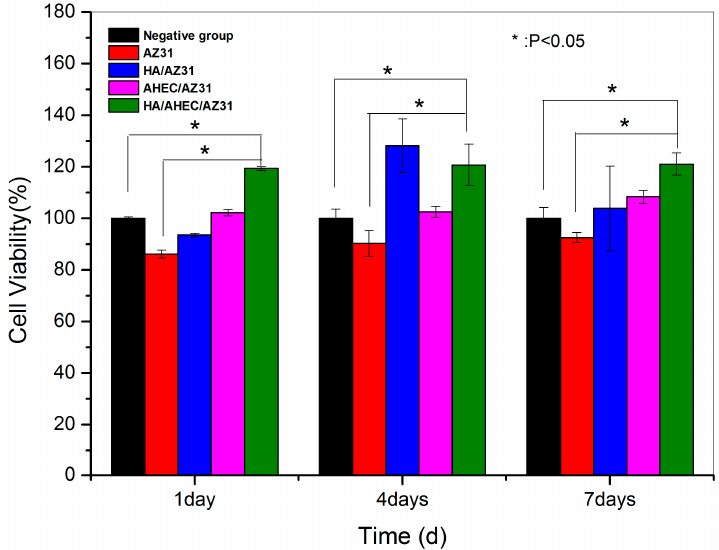
Figure 7. The cell viability of AZ31, HA/AZ31, AHEC/AZ31, and HA/AHEC/AZ31